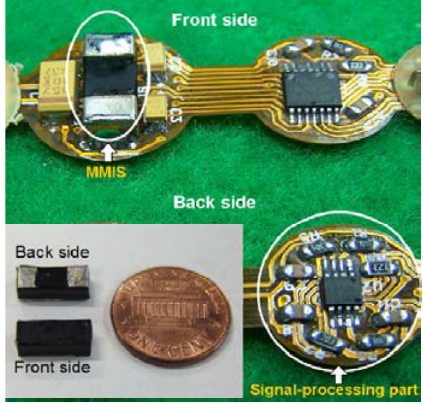
Figure 8. Photograph of MMIS and signal-processing part in turn-counting